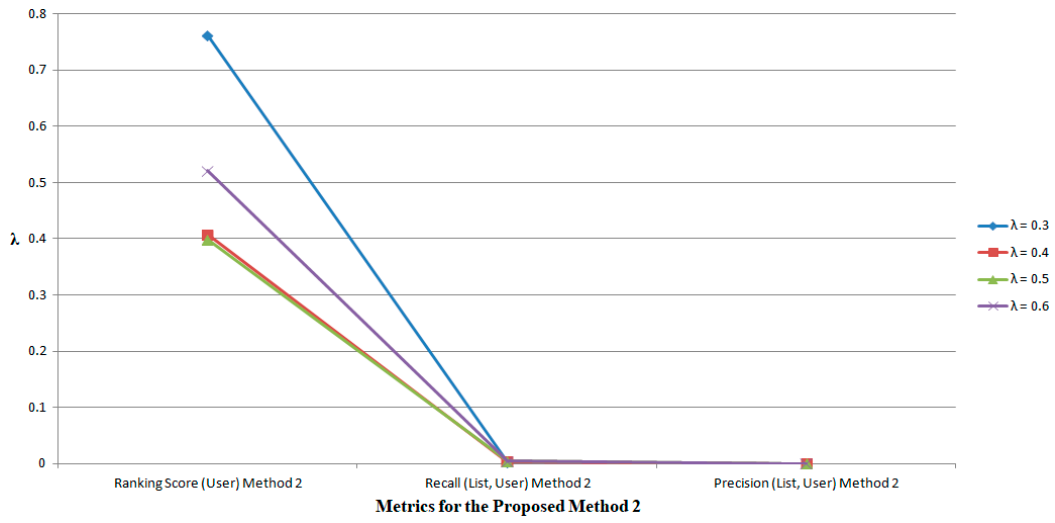
Figure 8. Performance of the Proposed Method 2 for Different Values of λ : Book-Crossing .